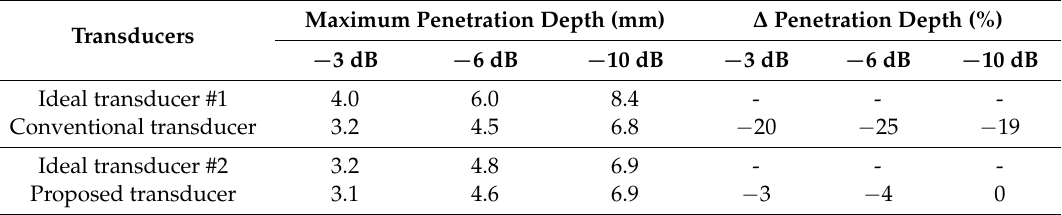
Figure 5. Simulated pressure fields of four transducers: ( a ) Ideal transducer #1; ( b ) conventional transducer; ( c ) ideal transducer #2; and ( d ) proposed transducer. Each contour plot indicates −3 dB, –6 dB, and −10 dB pressure distribution. Table 6. Penetration depth calculation by using pressure field simulation results compared with ideal transducers.